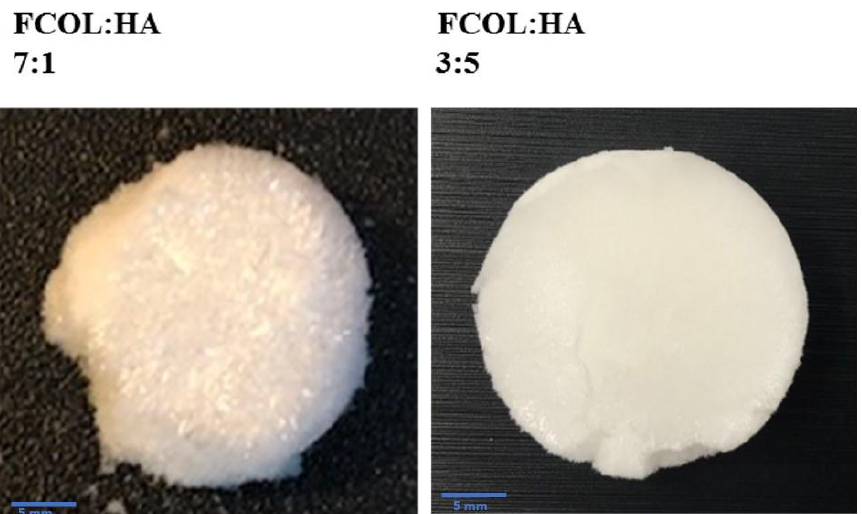
FCOL:HA 7:1 (Figure 1). Nevertheless, composite scaffolds comprising three polymers (SA:FCOL:HA) using SA with lower G content (SA#) produced clear and homogenous